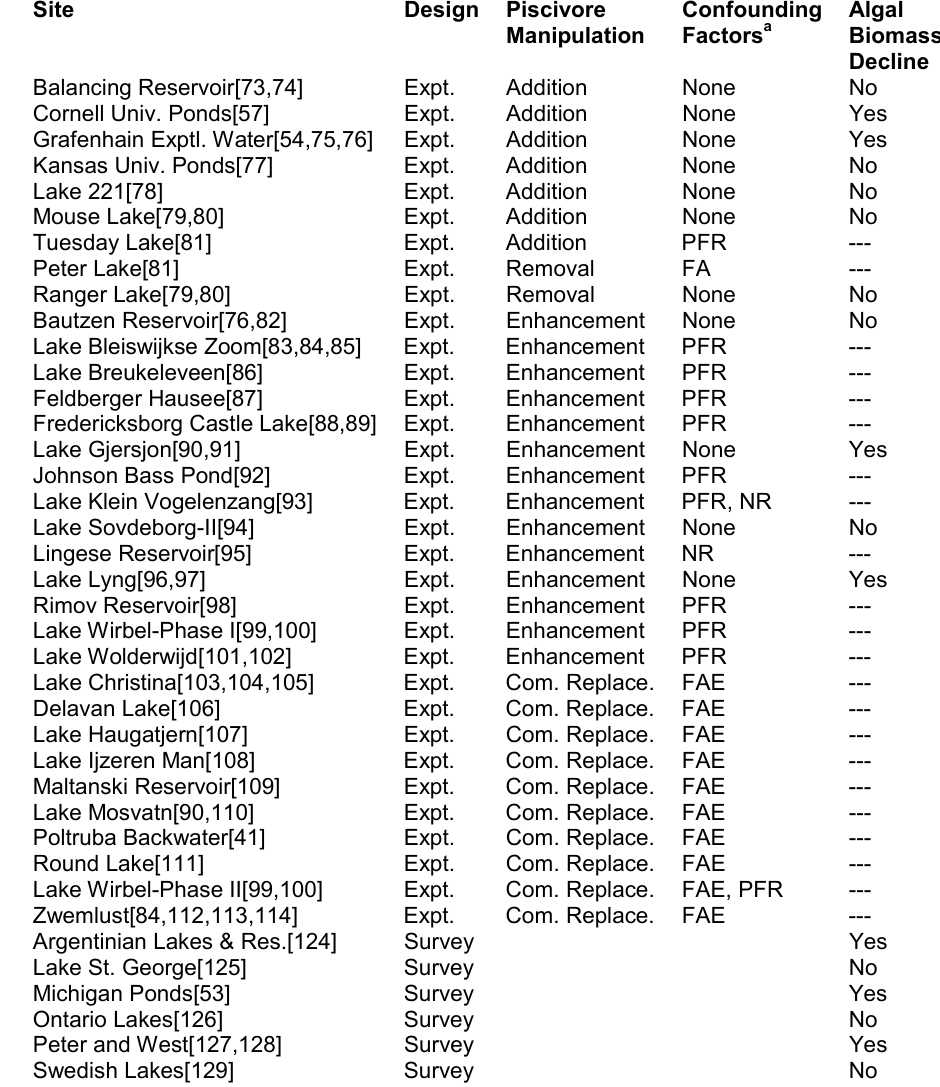
Experimental Studies and Field Surveys Examining the Effects of Manipulations of Populations of Piscivorous Fish on Phytoplankton Biomass Site